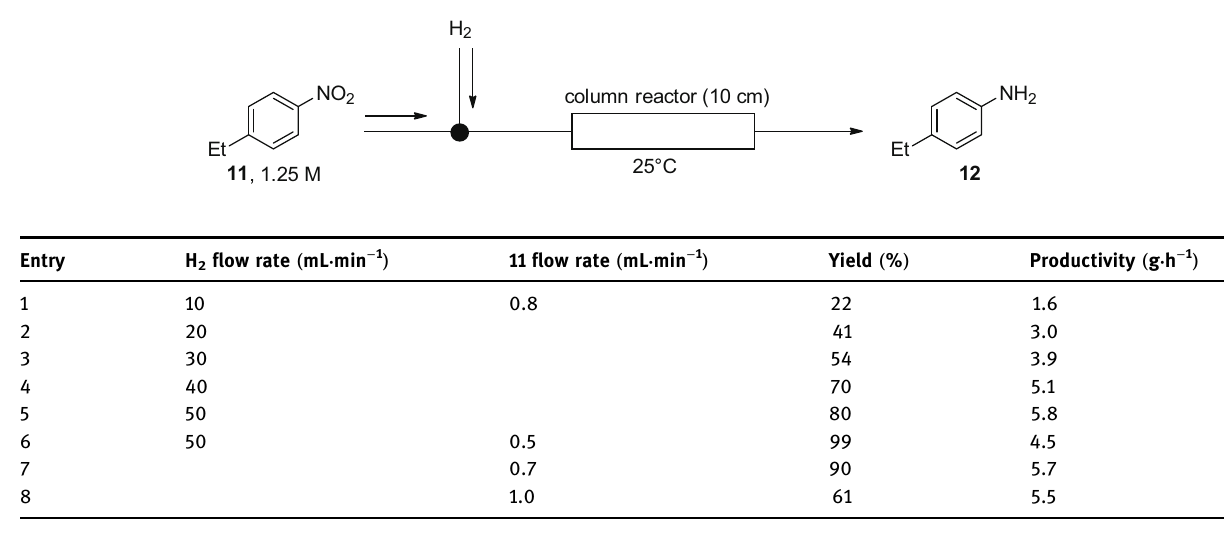
Table 3: Optimization of fl ow hydroxylation of nitro compounds a